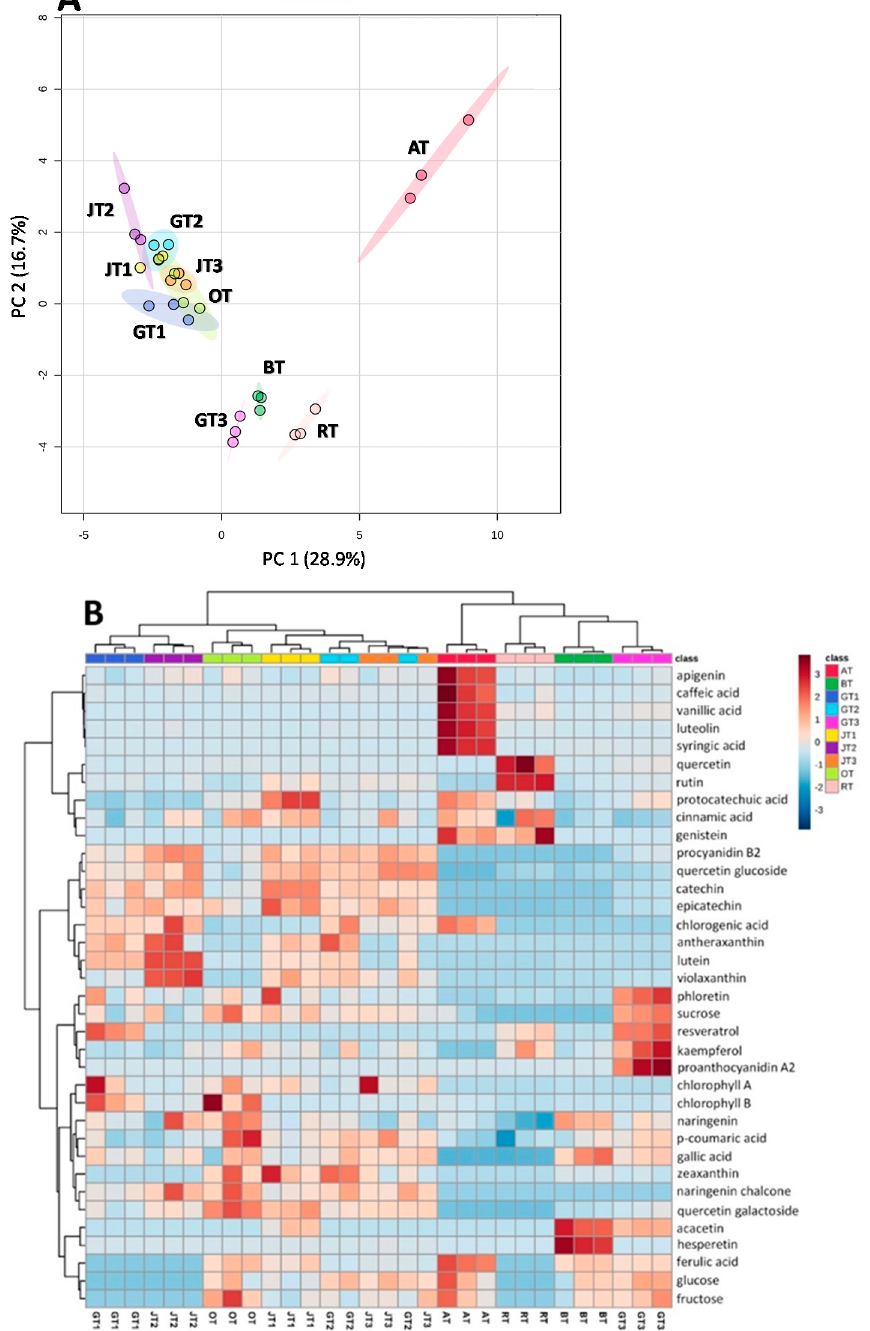
Figure 3. Principal component analysis ( A ) and heatmap ( B ) of phenolic, carotenoid and monosaccharide data of the studied teas and herbal teas.